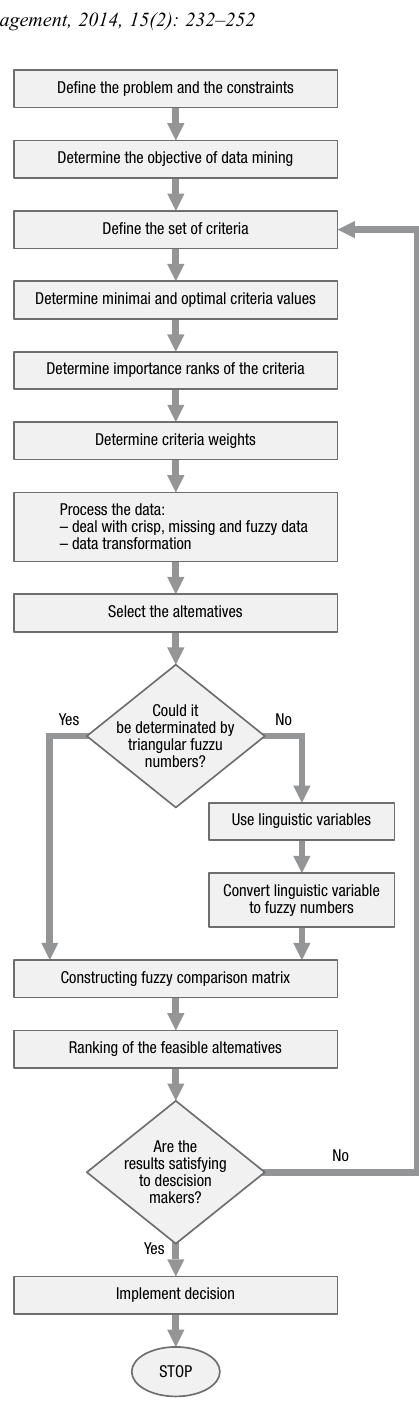
Fig. 2. The multiple-criteria expert system for personnel